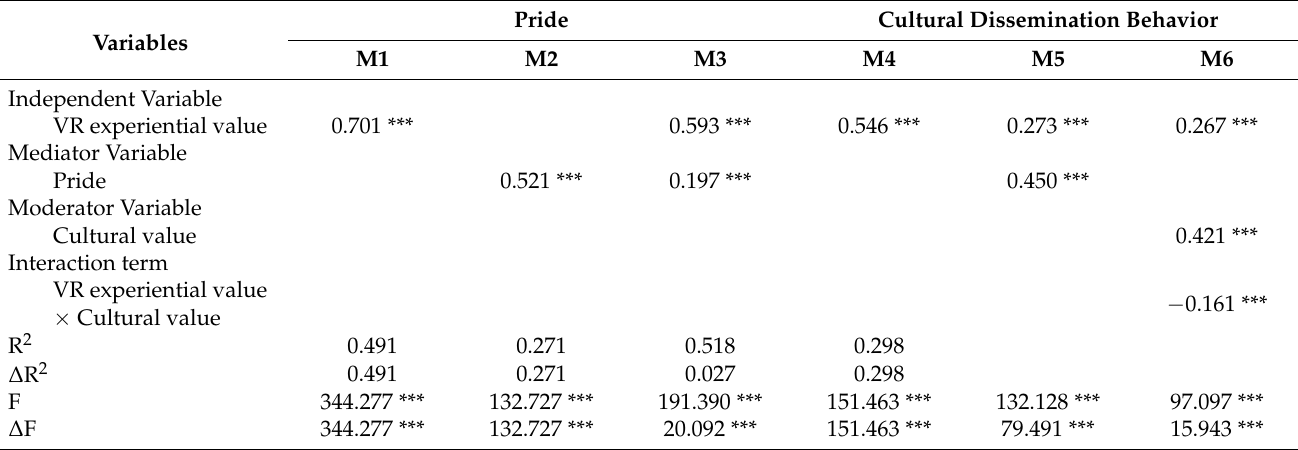
Table 5. Results of hierarchical regression modeling.